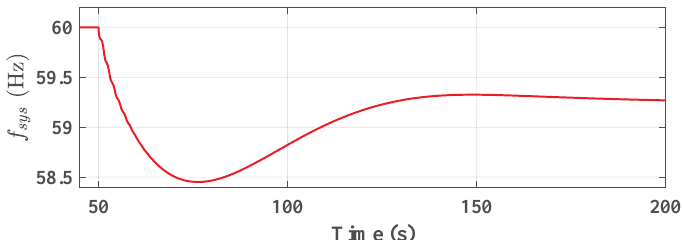
Figure 7. The PE-based power system frequency response to the generator 5 trip at t = 50 s for the PE-based power system case study (case study